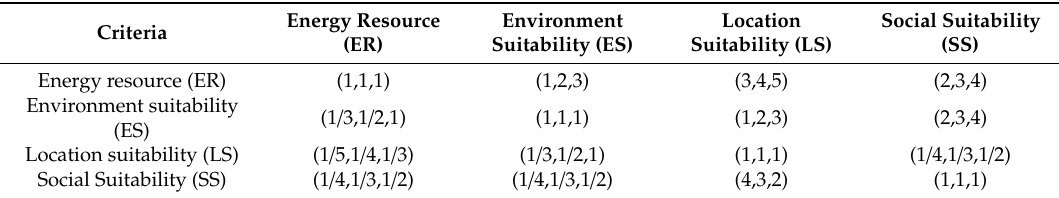
Table 4. Fuzzy comparison matrices for